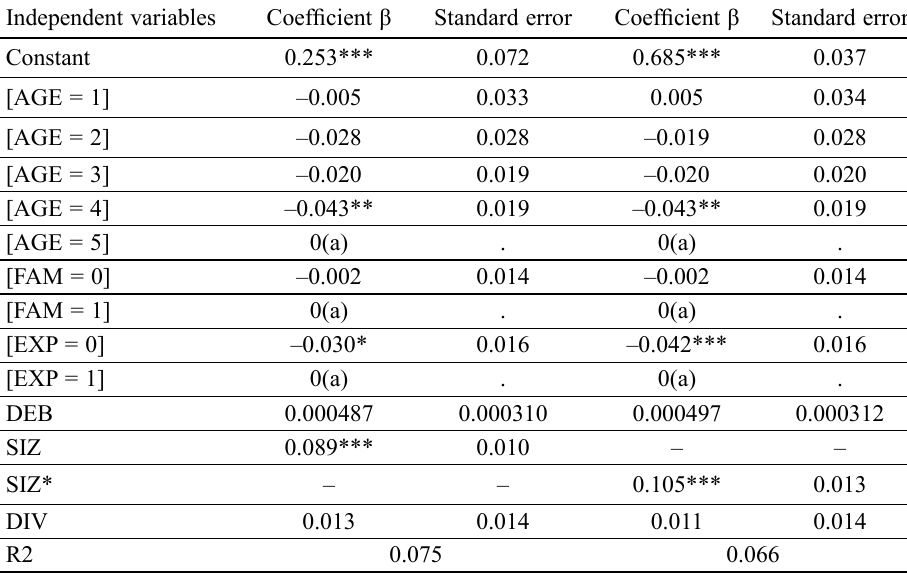
Table 6. Model 1. Dependent variable